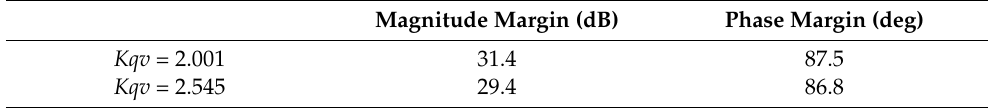
Table 5. Power stage stability